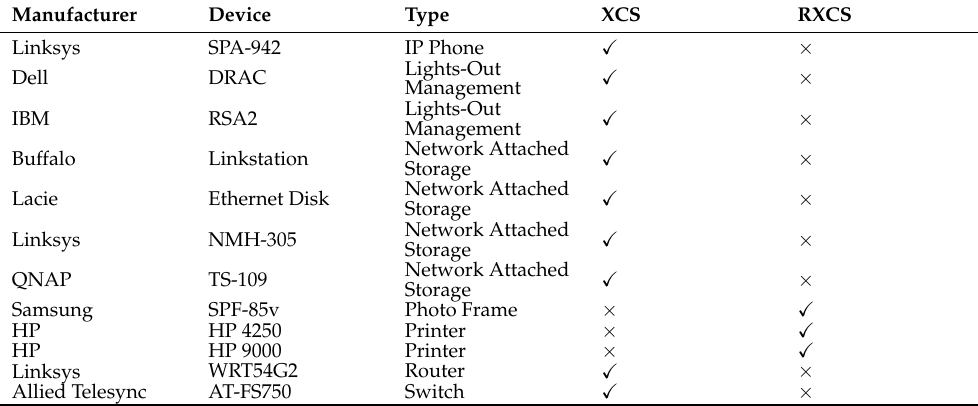
Table 2. Device vulnerability list.